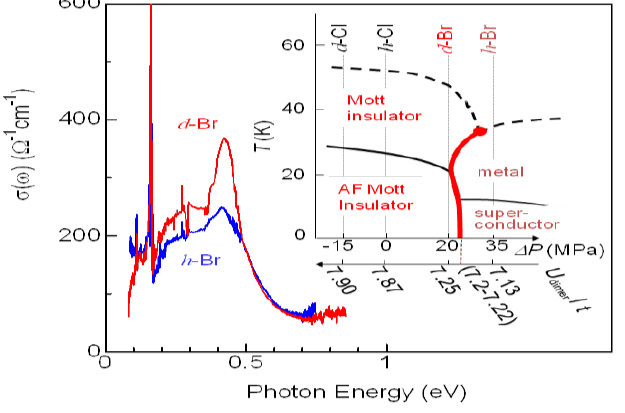
Figure 18. Optical conductivity  (  ) spectra of d -Br (red) and h -Br (blue) at 10 K.